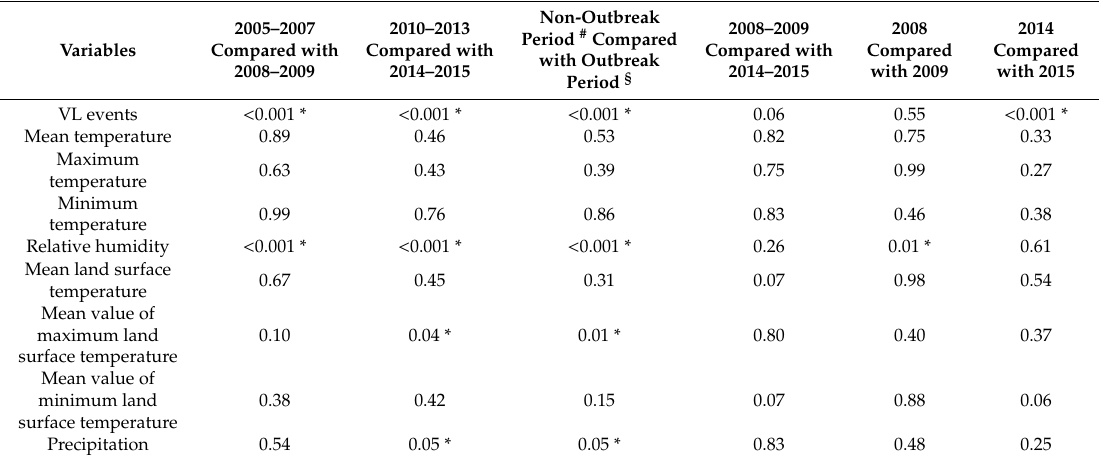
Table 6. Significant levels of meteorological di ff erences among the five